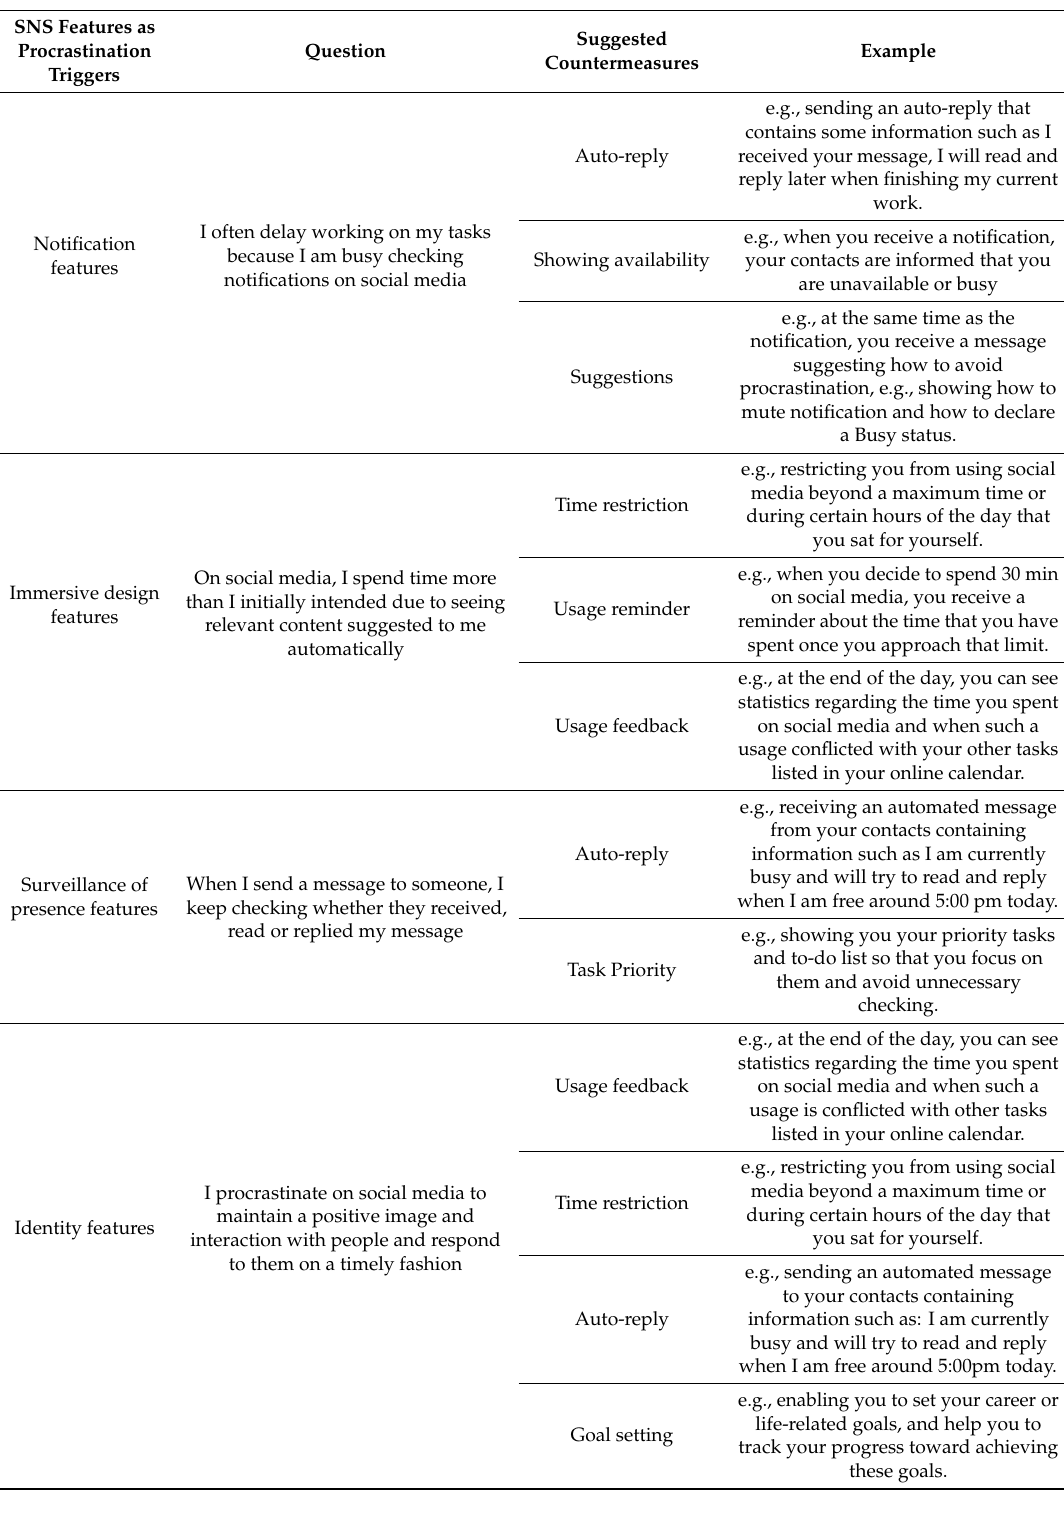
Table 4. Social networking site (SNS) Features as procrastination triggers and their suggested